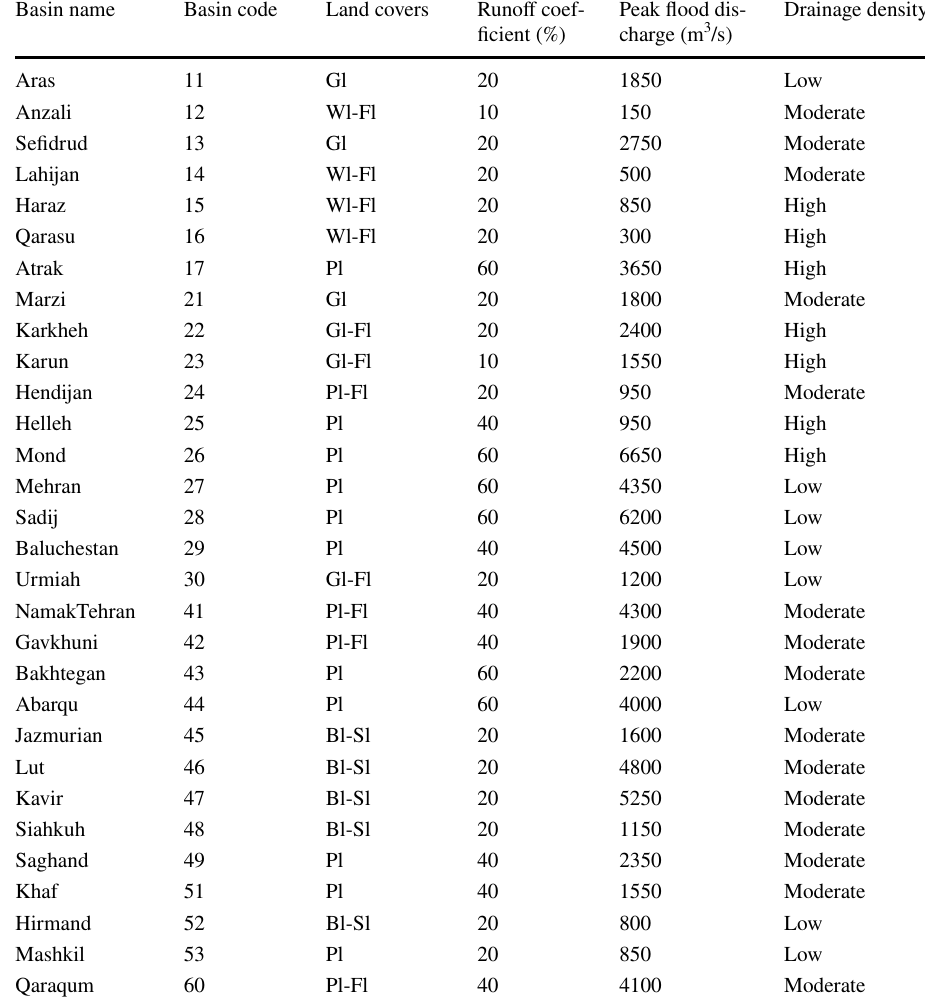
Table 7 Inventory of environmental variables of 30 major hydrological basins in Iran, including land covers, runoff coefficient, average of peak flood discharge, and drainage